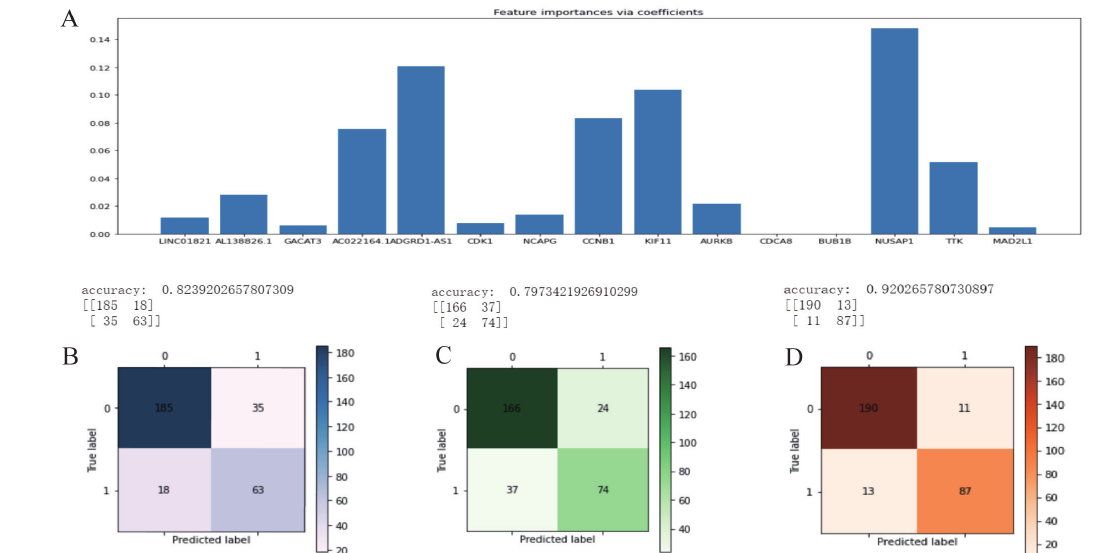
Figure 6. Feature selection and machine learning. (A) The initial screening of 15 genes by the “Feature Importance” algorithm and further screening of 10 key genes; (B) the NBC algorithm model; (C) the KNN algorithm model; (D) the RF algorithm model